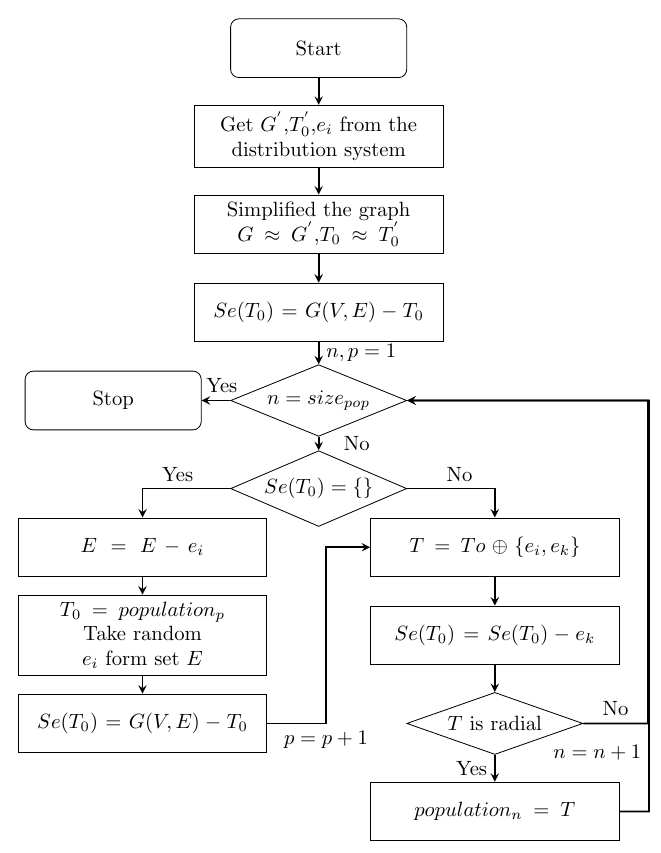
Figure 5. Flowcharts for the proposed MST